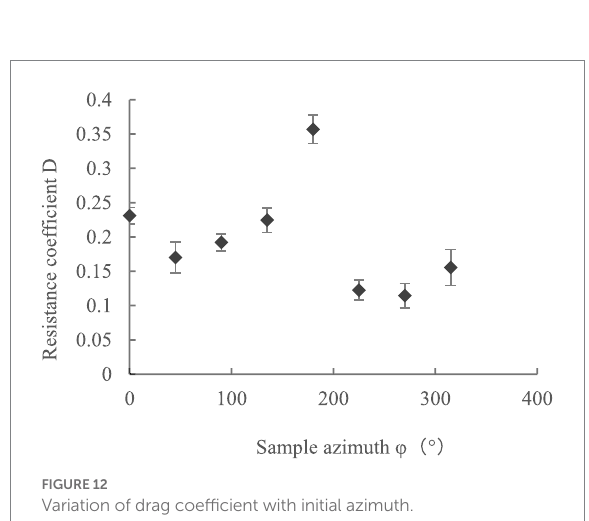
FIGURE 12 Variation of drag coefficient with initial